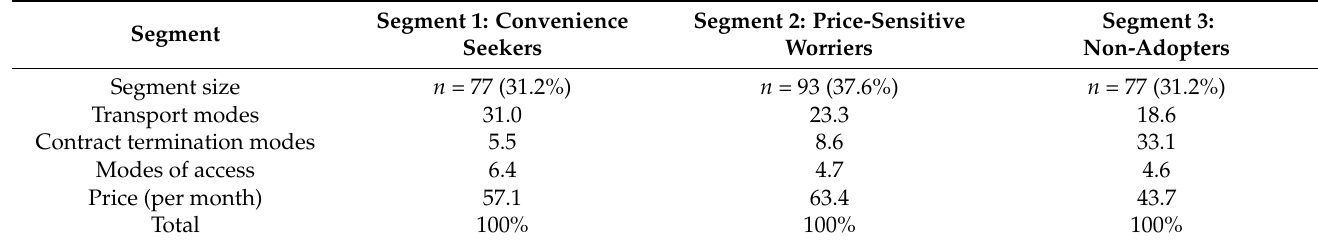
Table 5. Attribute importance scores per